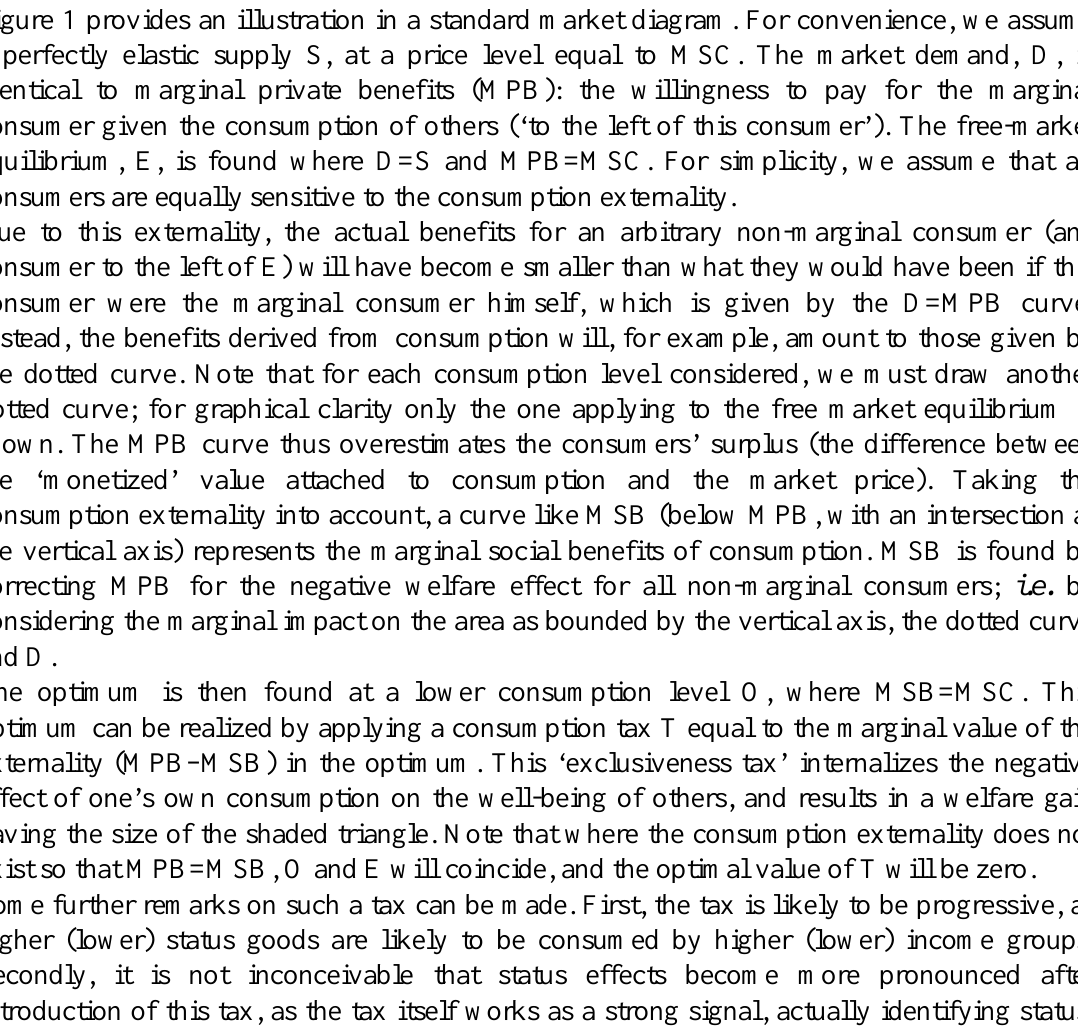
Figure 1. Negative consumption externalities for a homogeneous